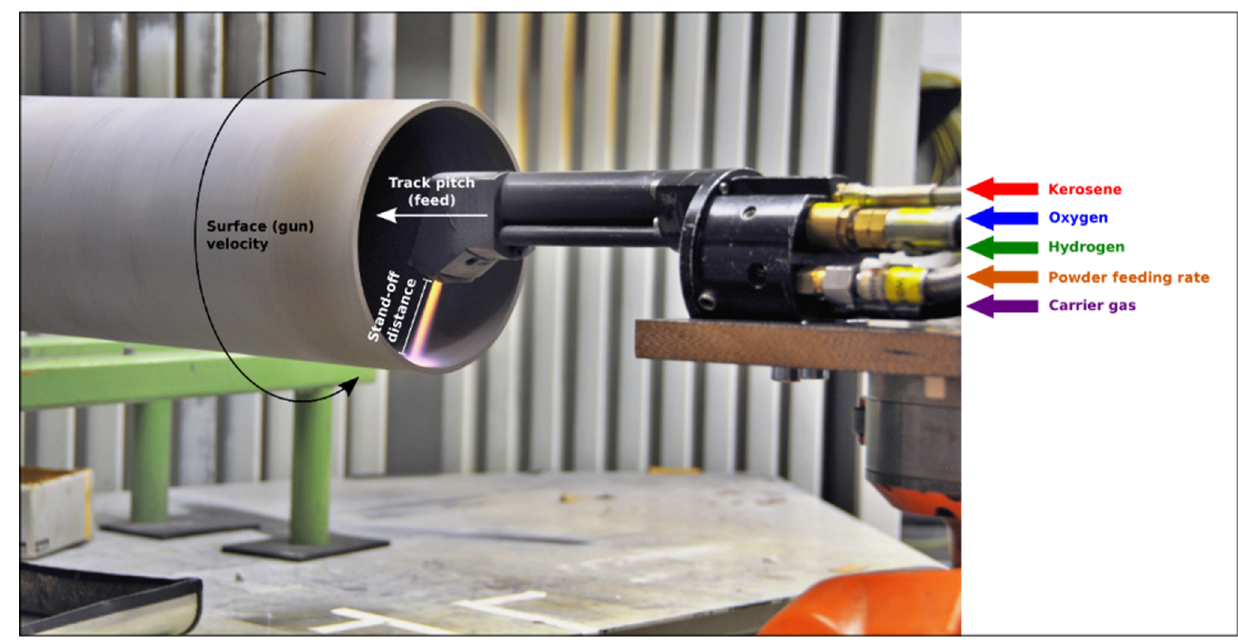
Figure 1. ID HVOF spraying process with relevant influencing parameters.